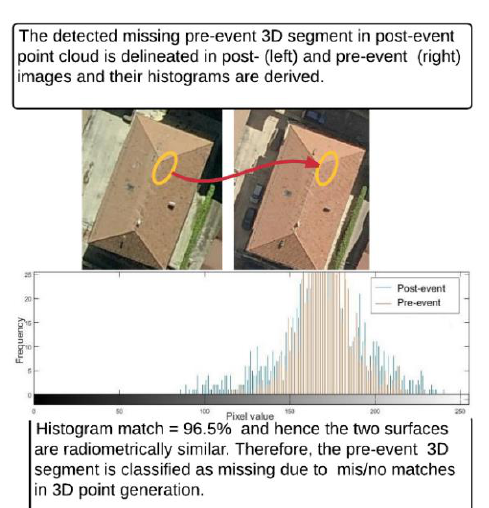
Figure 7. Example for missing 3D segment classified as mis/no matches in 3D point generation.